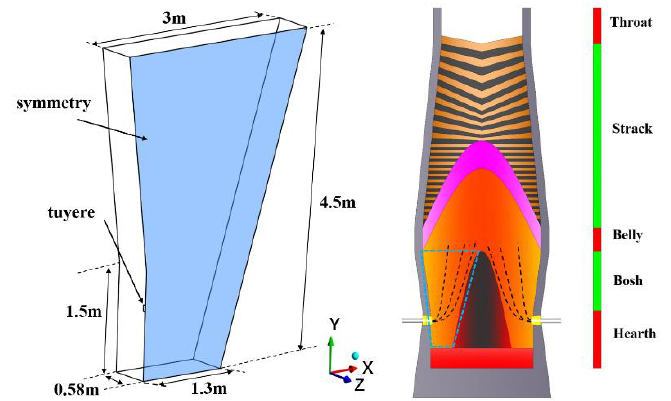
Figure 1. Blast furnace (BF) schematic and geometry model of the calculation domain.